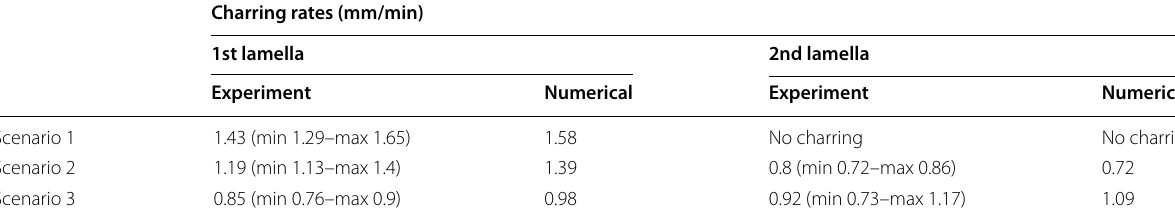
Table 3 Charring rates for different fire scenarios